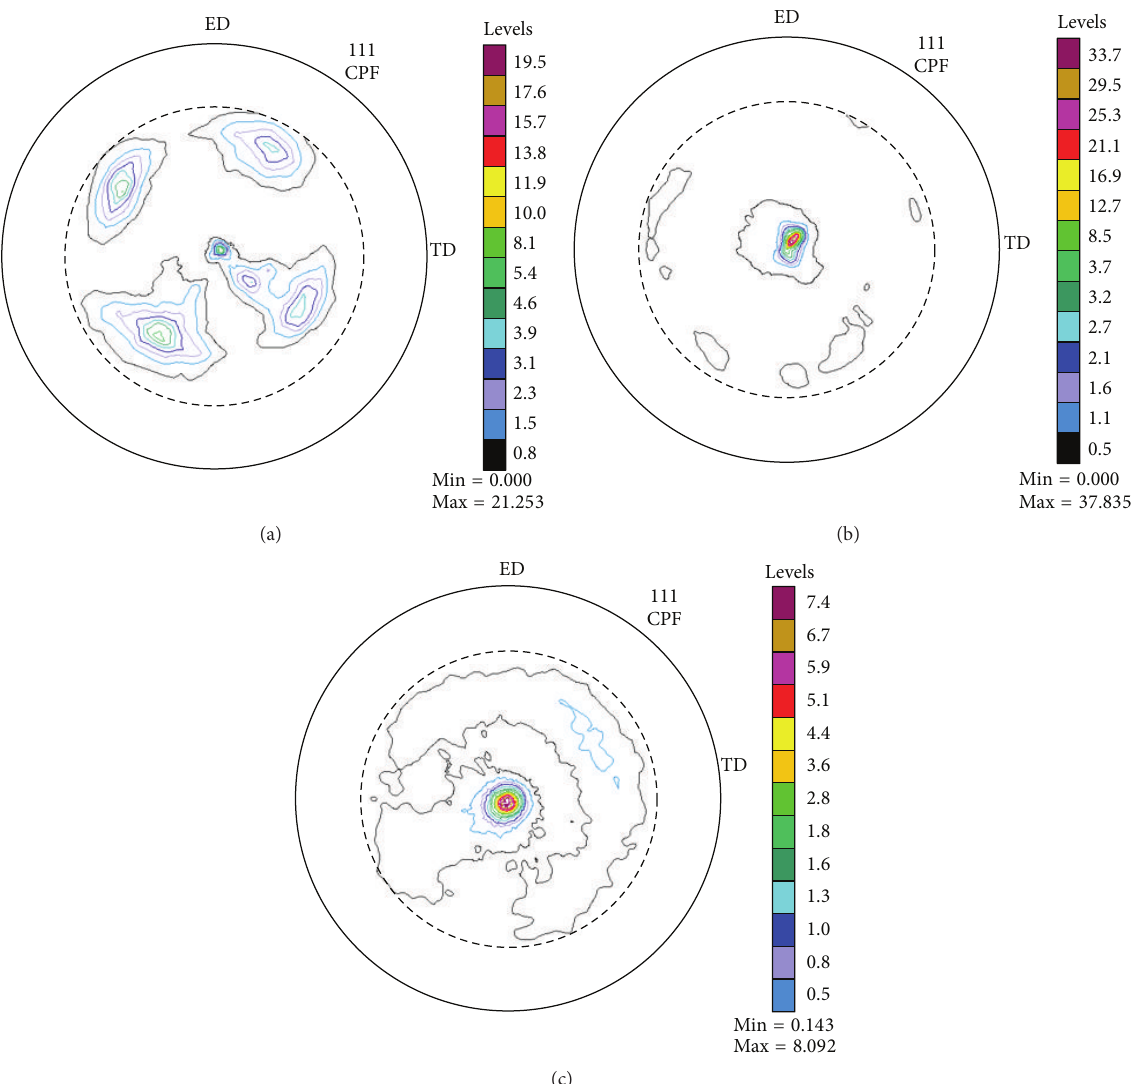
Figure 4: {111} pole figures determined experimentally for ⟨100⟩ (a) and ⟨110⟩ (b) Ni single crystals and Ni polycrystal (c) deformed to 𝜀 = 1.2 .